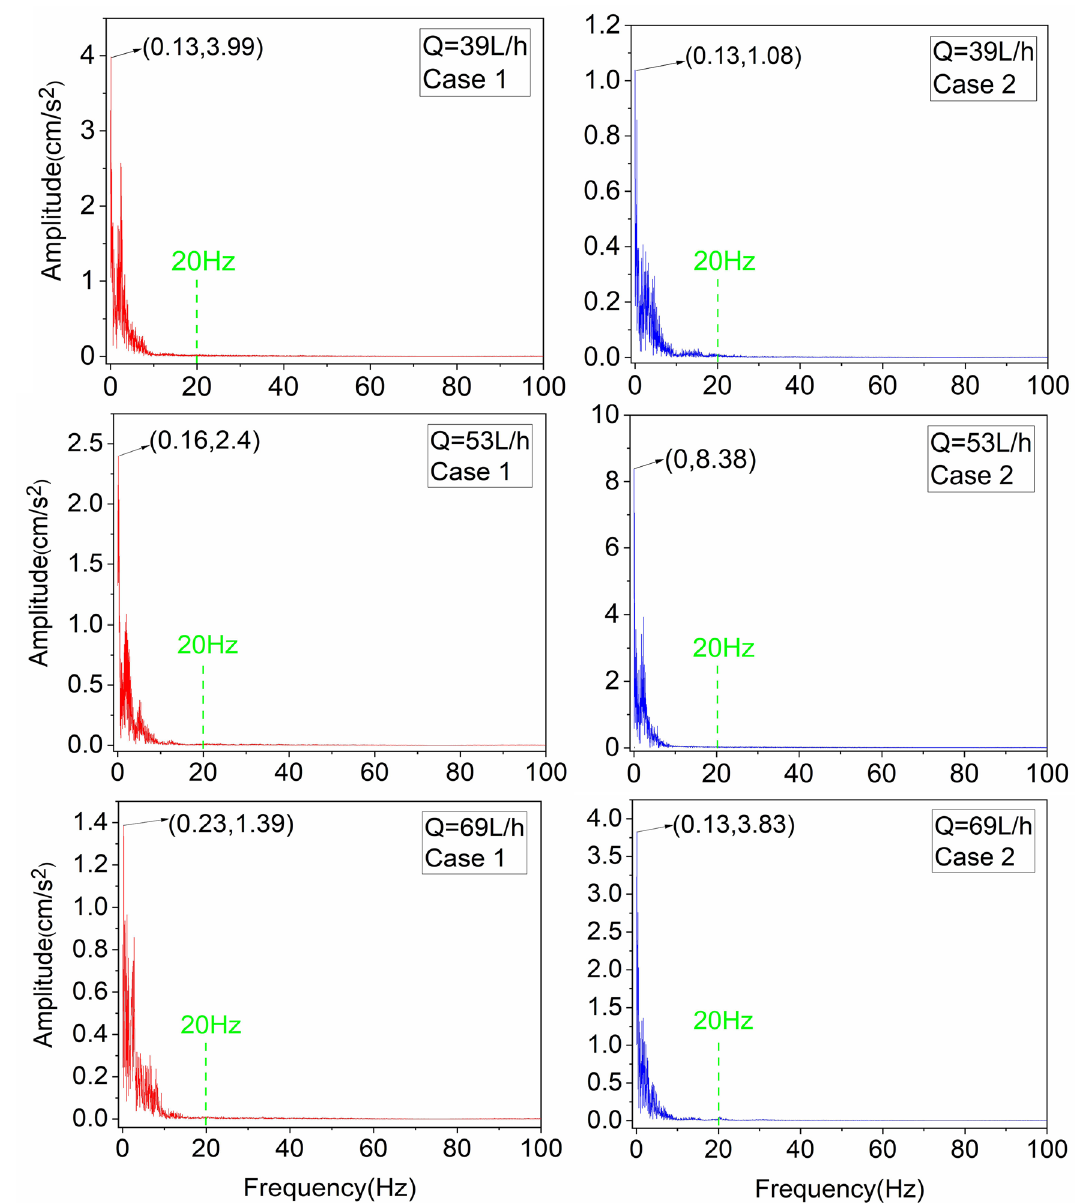
Figure 4. Frequency spectrum of pebble vibration acceleration at different flow rate. The pictures represent different working conditions: Q = 39 L/h, Q = 53 L/h, Q = 69